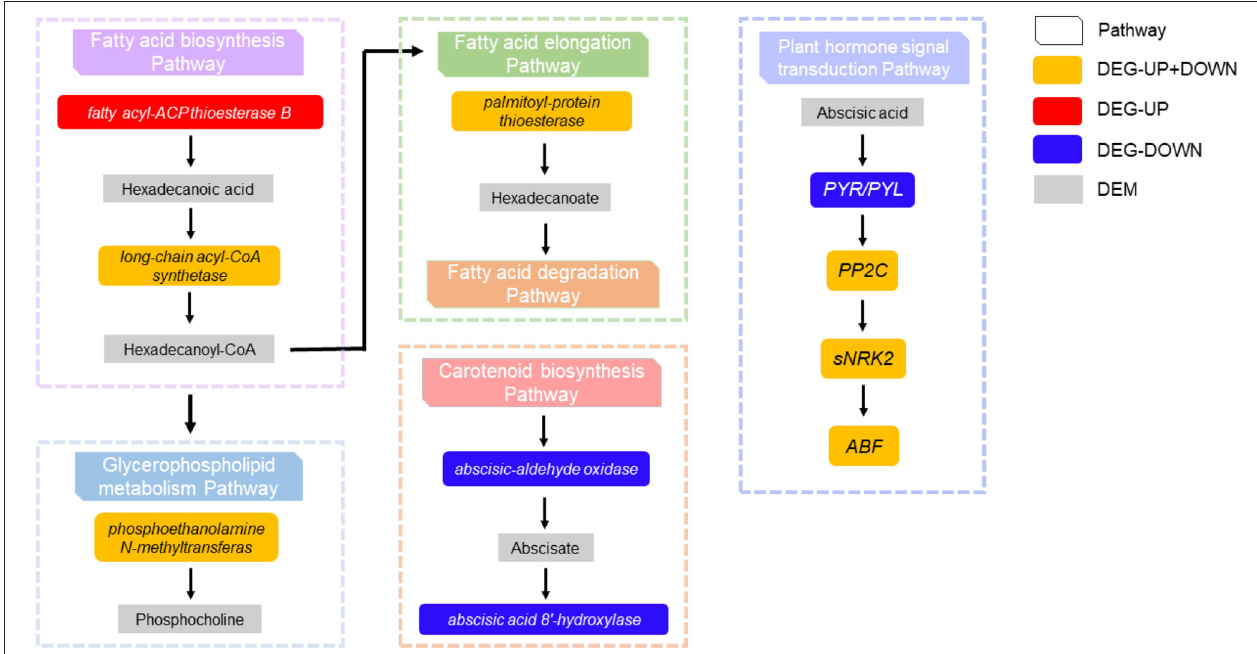
FIGURE 6 | The interaction between DEGs and differentially expressed metabolites were found in the fatty acid biosynthesis pathway, glycerophospholipid metabolism pathway, fatty acid elongation pathway, carotenoid biosynthesis pathway, and plant hormone signal transduction pathway.